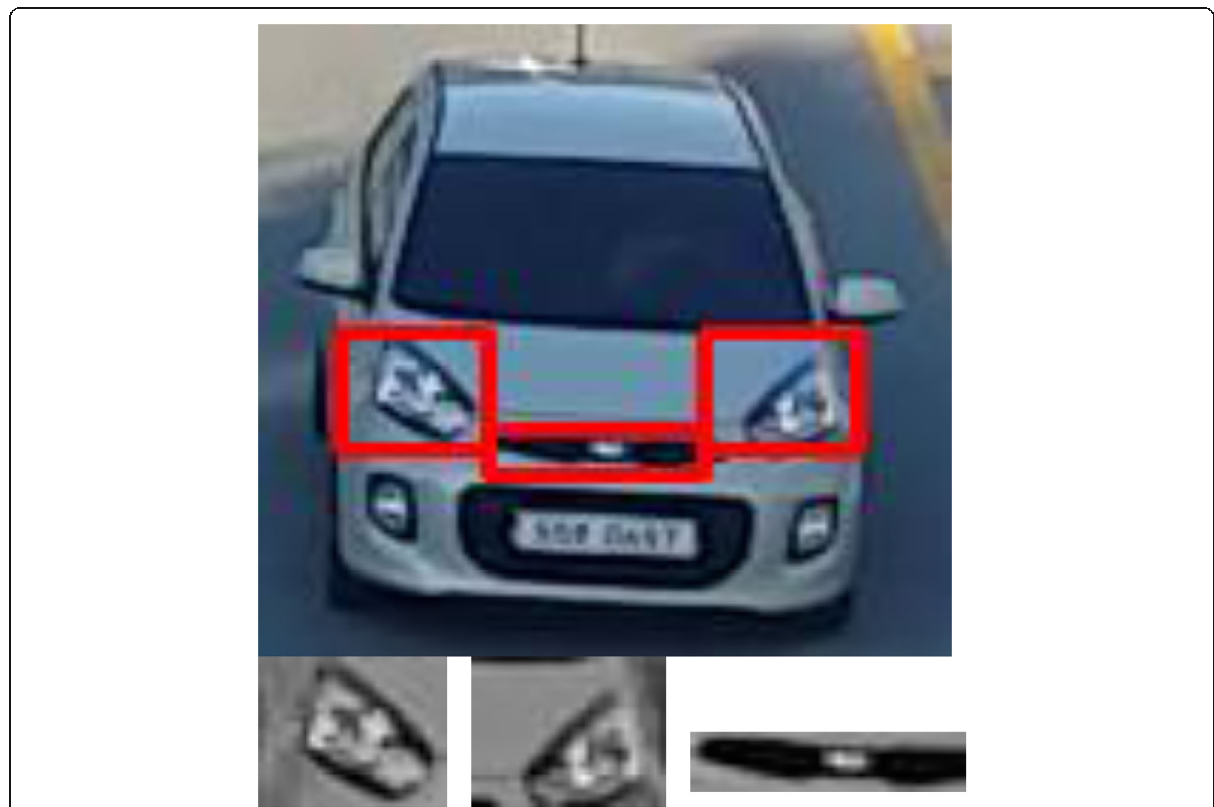
Fig. 5 ROIs extracted from the detected vehicle as shown in Fig.